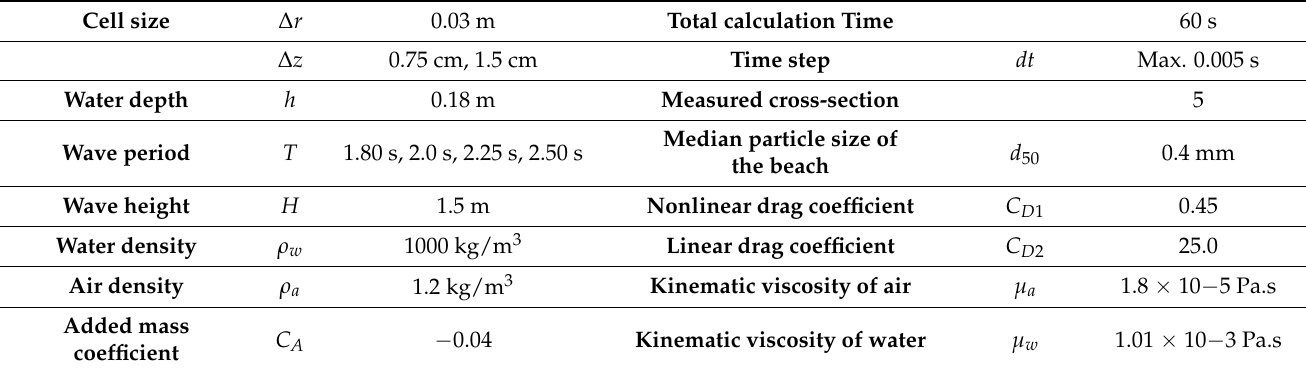
Table 2. Numerical computation conditions for wave generation.